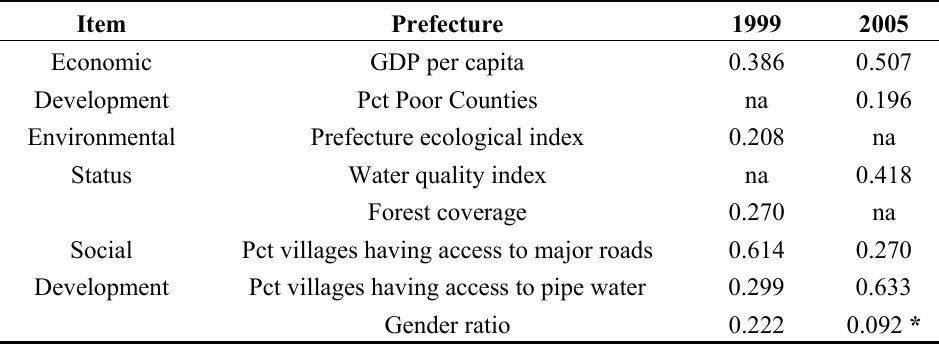
Table 3. Results from the two-sample t